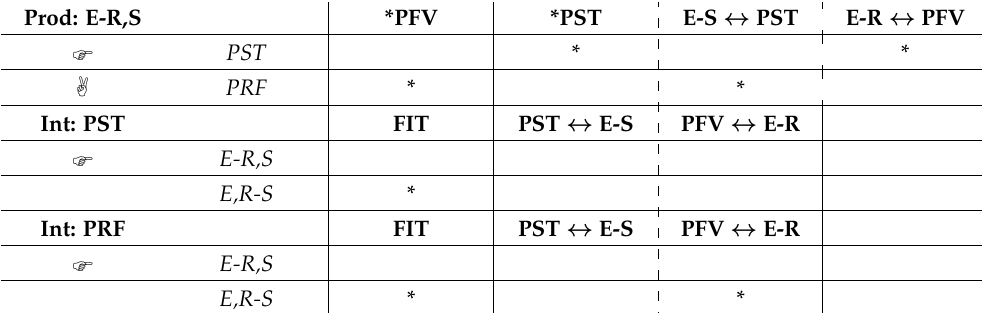
Tableau 2. Asymmetrical optimization in English and Spanish (example (12)). Tableau 1. Bidirectional optimization of tenses.